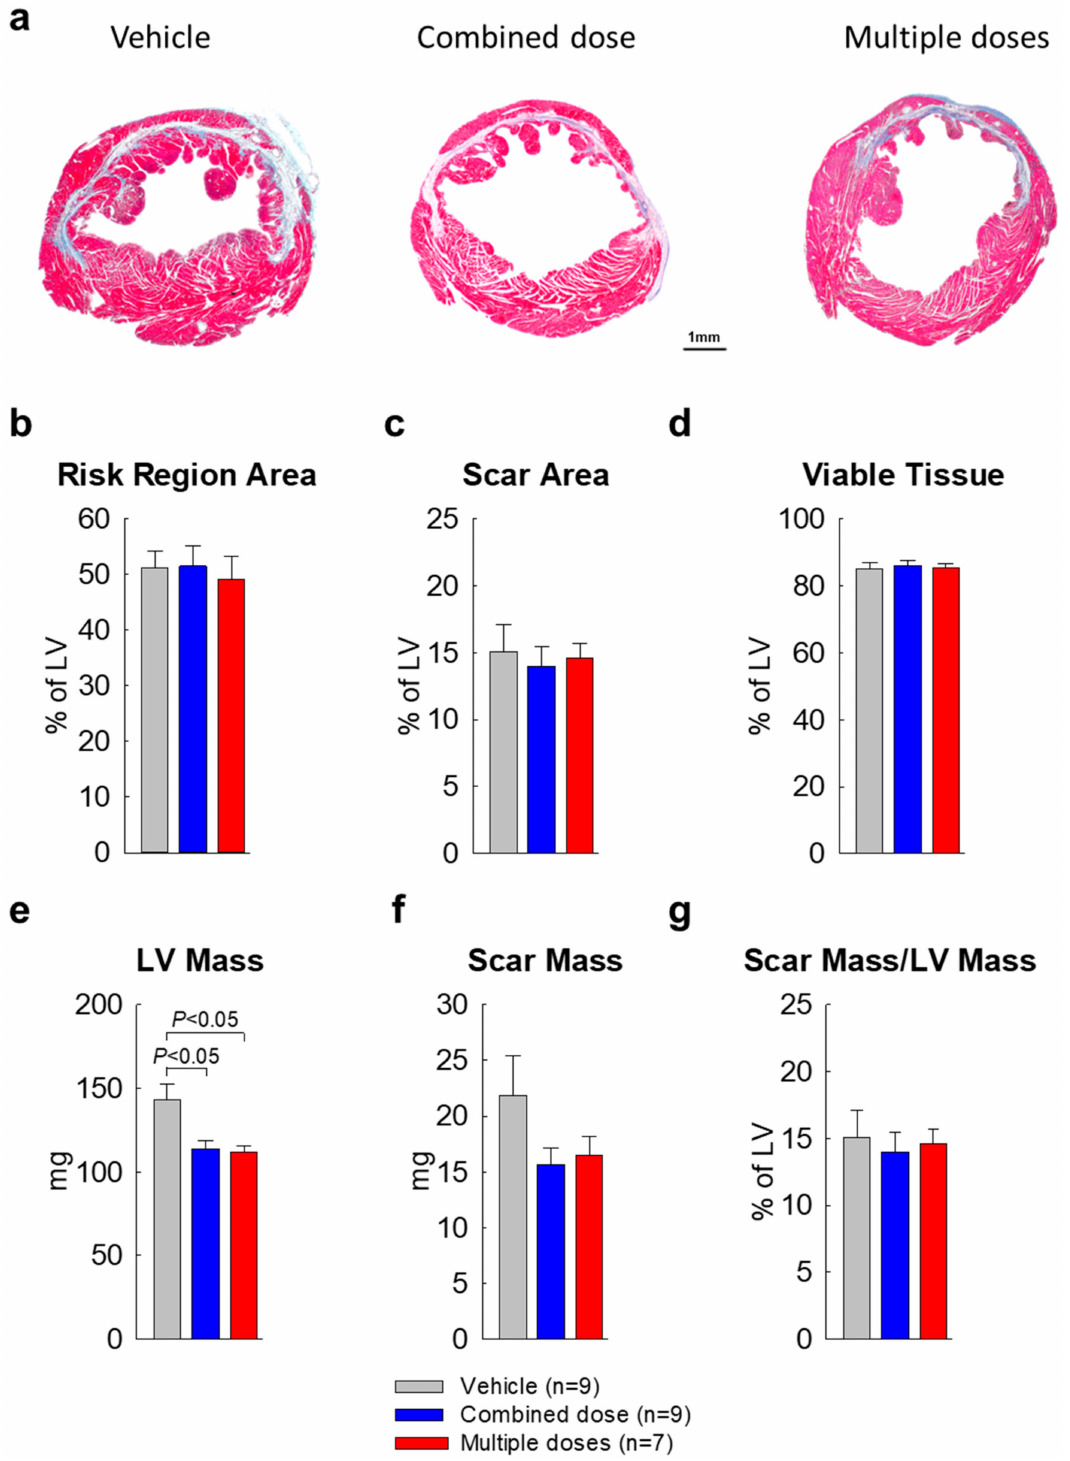
Figure 4. Morphological and histological assessments ( n = 7~9/group). Masson’s trichrome–stained images were used for LV morphological measurements. ( a ) Representative Masson trichrome-stained myocardial sections. Scar tissue and viable myocardium are identified in white/blue and red, respectively; ( b ) Risk region area as percentage of LV area; ( c ) Scar area as percentage of LV area; ( d ) Viable tissue area as percentage of LV area; ( e ) LV mass; ( f ) Scar mass; ( g ) Scar mass/LV mass ratio. All data are represented as the mean ±